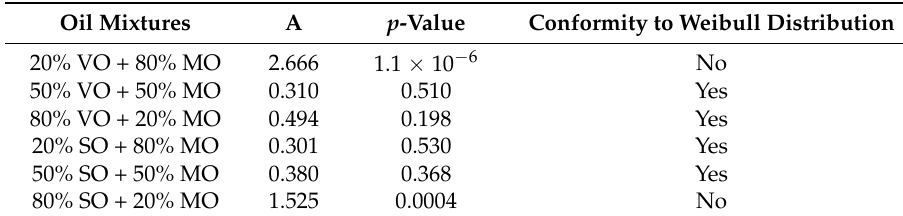
Table 10. Hypothesis test of conformity to Weibull distribution of oil mixtures in DC.